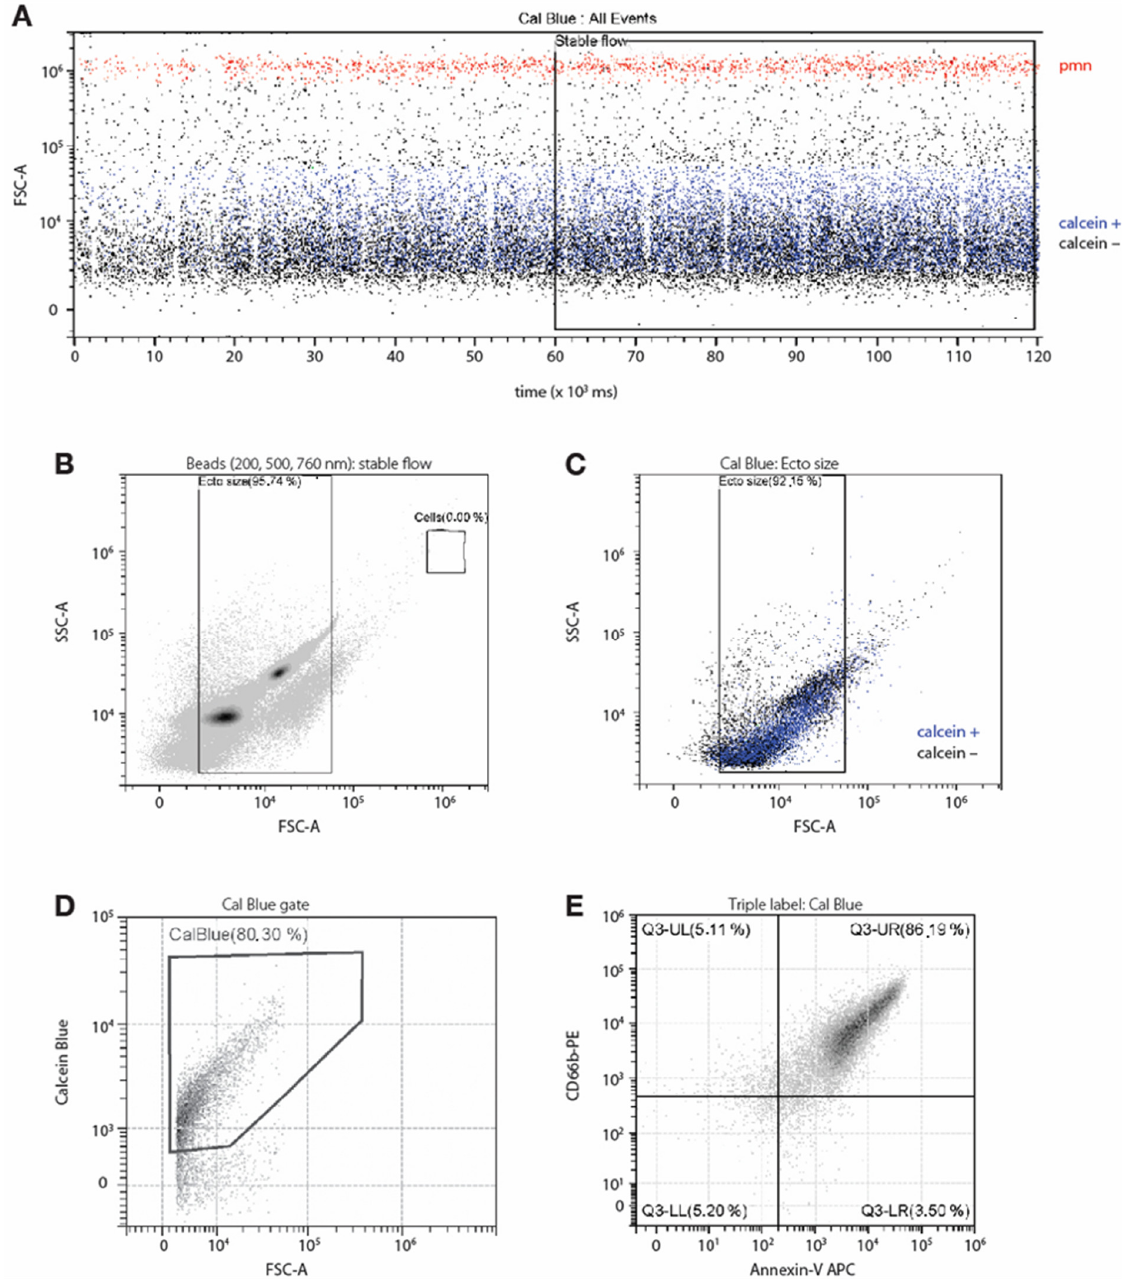
Figure 1. Characterization of neutrophil EVs by high resolution flow cytometry. Neutrophils were cultured in the presence of 100 nM fMLP for 30 min; culture supernatants were collected, centrifuged (1000× g , 10 min, 4 °C) to pellet intact cells, and the resulting supernatants were spun again (18,000× g , 15 min, 4°C). The EV pellets were resuspended in 0.2 µ filtered HBSS and stained with Calcein Blue AM, prior to flow cytometry analyses. ( A ) Calcein-stained EV suspensions (blue) spiked with intact neutrophils (red) were monitored over time and data acquisitions were started after 1 min, i.e., when fluctuations in the cell and event numbers had stabilized. ( B ) Analysis of EV suspensions spiked with cytometry calibration beads (measuring 200, 500 and 760 nm) identified a region in which ectosomes are expected to localize and a size gate was established between 100 and 760 nm. ( C ) Distribution of calcein-stained EV suspensions (blue) from cultured neutrophil supernatants within this size gate. ( D ) Analysis of EVs for calcein fluorescence was used to set a gate for calcein-positive events. ( E ) Analysis of calcein-positive EVs for CD66b and Annexin-V fluorescence. Triple-positive EVs identified thusly are considered NDEs. The experiment shown in this figure is representative of NDE counts throughout the article.